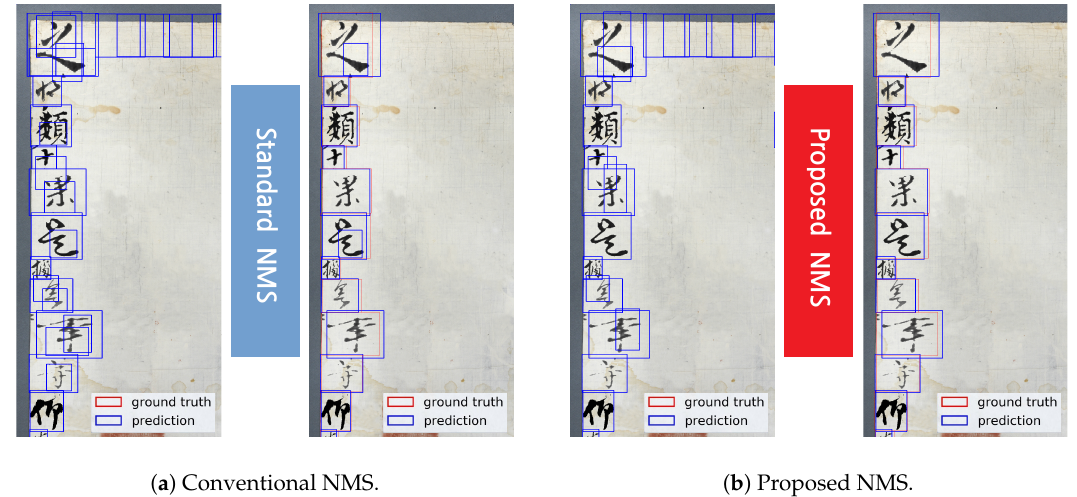
Figure 4. Comparison of the results of conventional and proposed NMS for duplicate detection